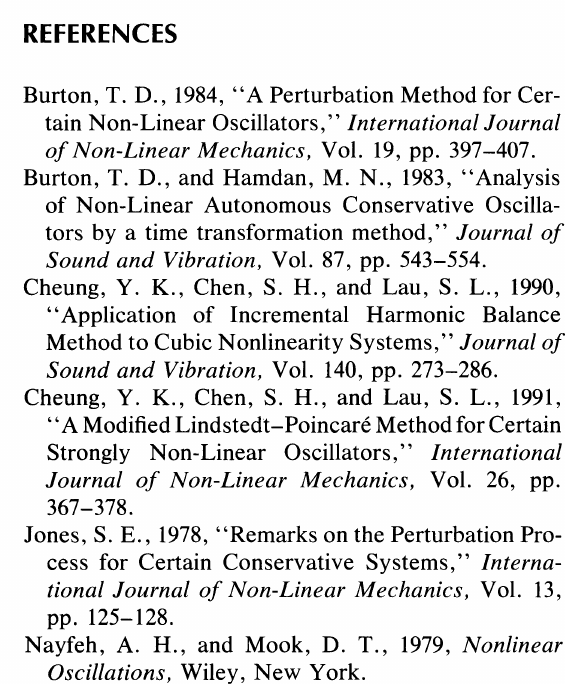
tion. If eWI > wo, then the lower order solution fails and the higher order solution also loses its effectiveness, and at times may even yield a worse solution. Therefore, any effort to try to obtain a more accurate solution by carrying out higher order perturbation is useless in the range of large